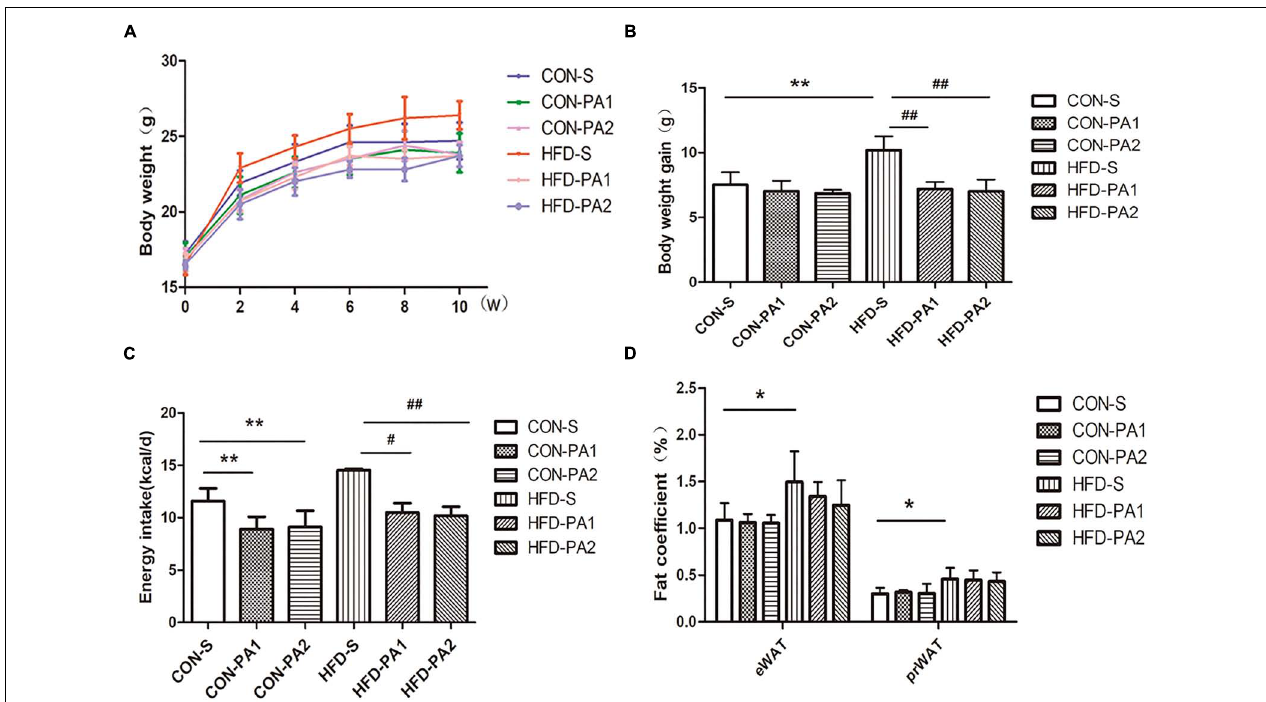
FIGURE 1 | Effects of exercise on body weight, body weight gain, energy intake, and visceral fat in juvenile mice. (A) Bodyweight change. (B) Comparison of body weight gain. (C) Comparison of energy intake. (D) Comparison of epididymal and perirenal fat coefficients. Compared with the CON-S group, * P < 0.05 and ** P < 0.01; compared with the HFD-S group, # P < 0.05 and ## P < 0.01.